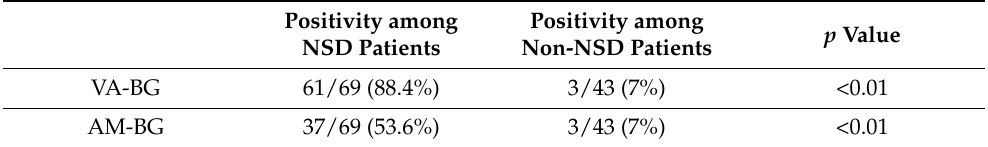
Table 1. Differentiation between NSD and non-NSD patients based on visual assessment and automated method-based assessment of 18 F-DOPA uptake in the basal ganglia.